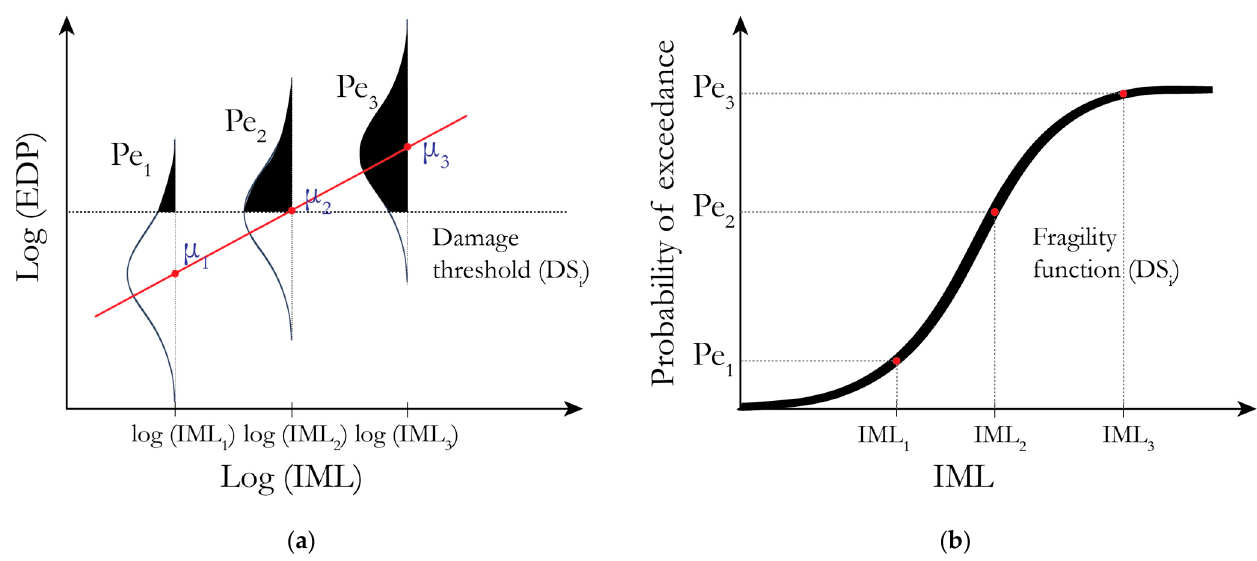
Figure 14. A schematic of the fragility assessment procedure: ( a ) probability of exceedance for three IMLs given a damage threshold; ( b ) Fragility function for a given damage state.